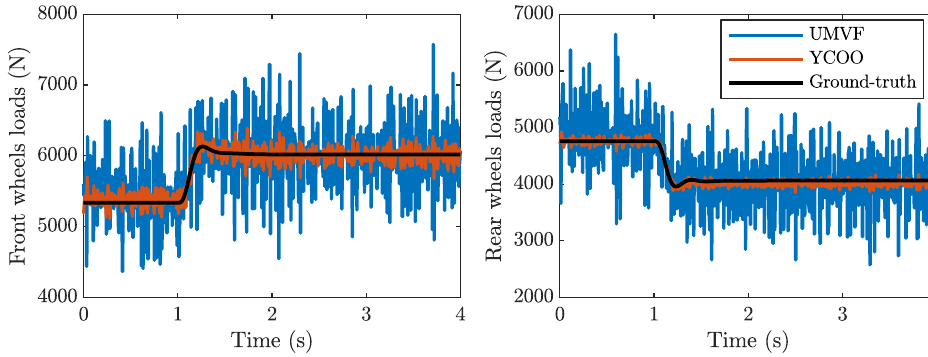
Figure 10. Estimation with noisy